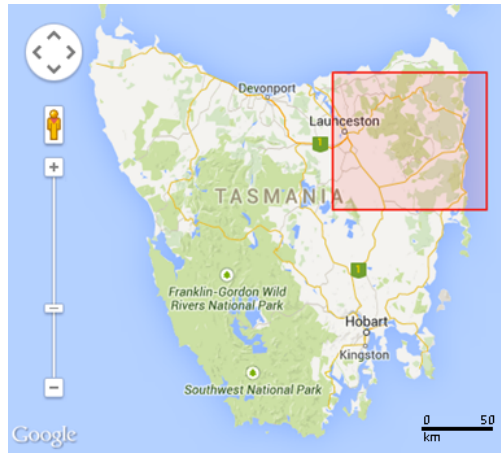
Figure 2. Map of Tasmania (Australia). The red colored rectangular area in the north east region indicates the Region of Interest (RoI) under study (South